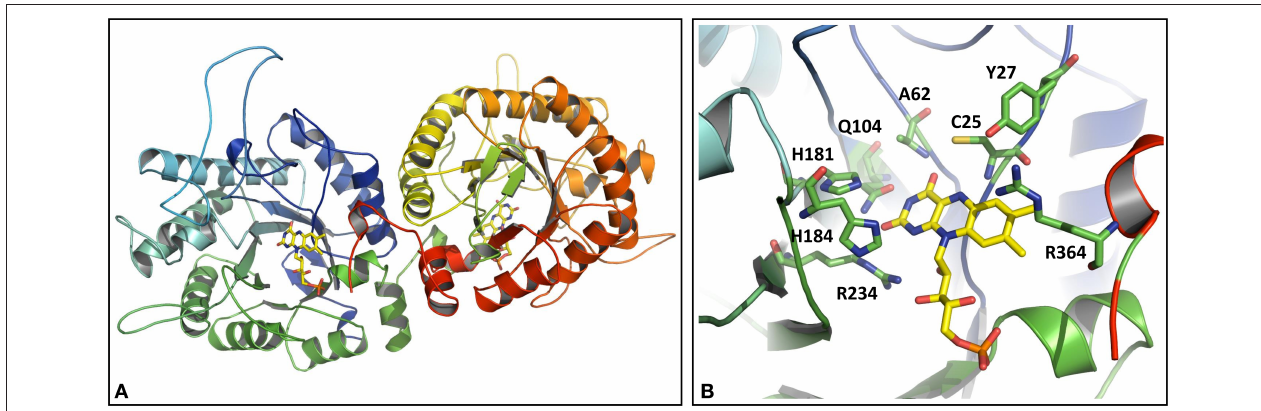
FIGURE 1 | Homology model of OYERo2a. (A) Three-dimensional model of the dimeric protein structure. The FMN prosthetic group is indicated in yellow. (B) Active site model. The side chains interacting with the flavin are shown in stick models (green) and colored by elements (red = oxygen-containing group; blue = nitrogen containing group). The FMN cofactor is shown as stick model and colored by elements with carbons in yellow. Note that R364 belongs to the adjacent subunit. C25 is in hydrogen bonding distance to the O4-atom of the isoalloxazine ring of the flavin.